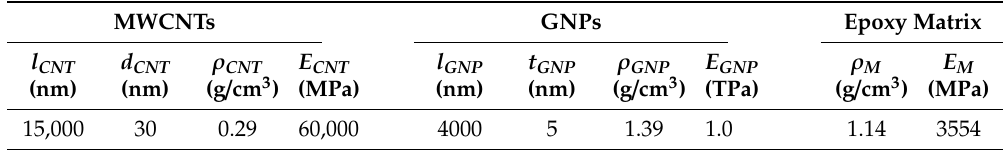
Table 2. Synergistic indexes for the studied mechanical properties. (%).